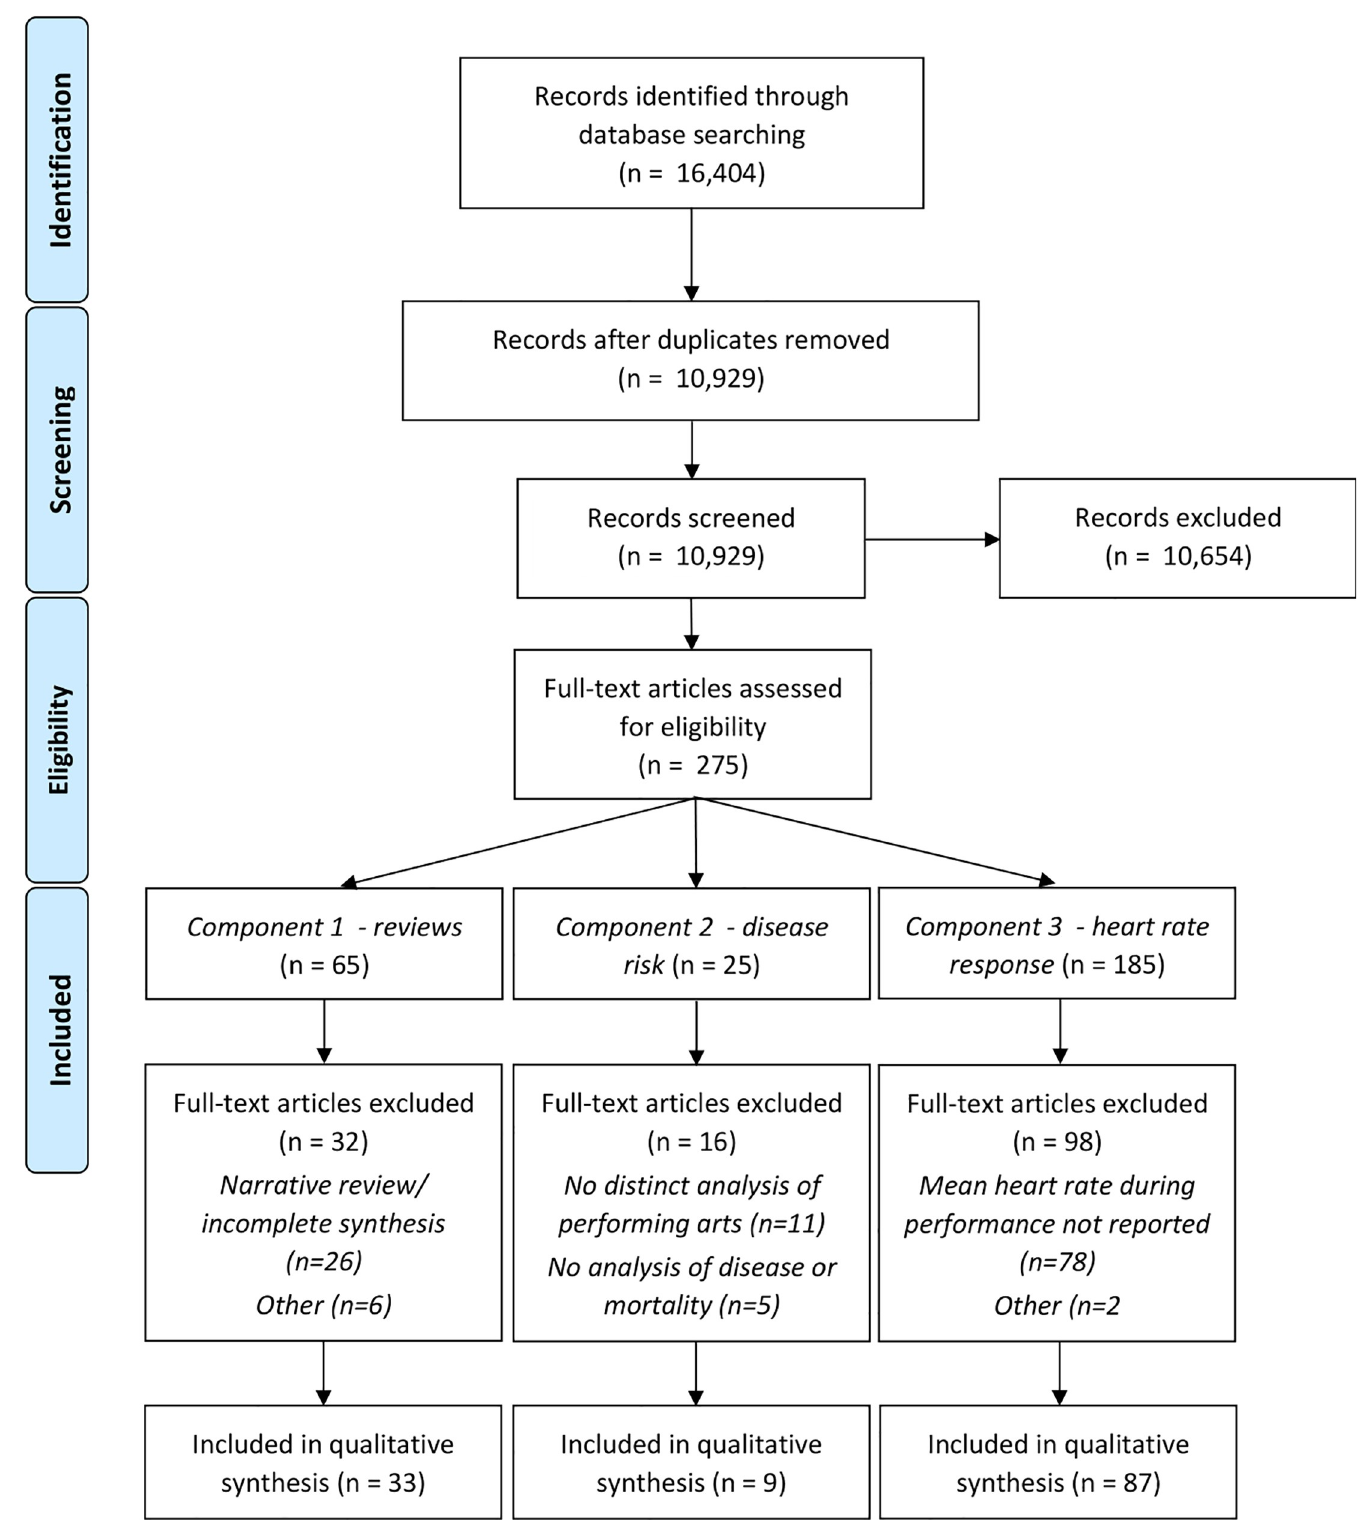
Fig 1. PRISMA diagram [27] detailing umbrella review results. Specific details regarding excluded reviews/studies are contained in the S1 Appendix.